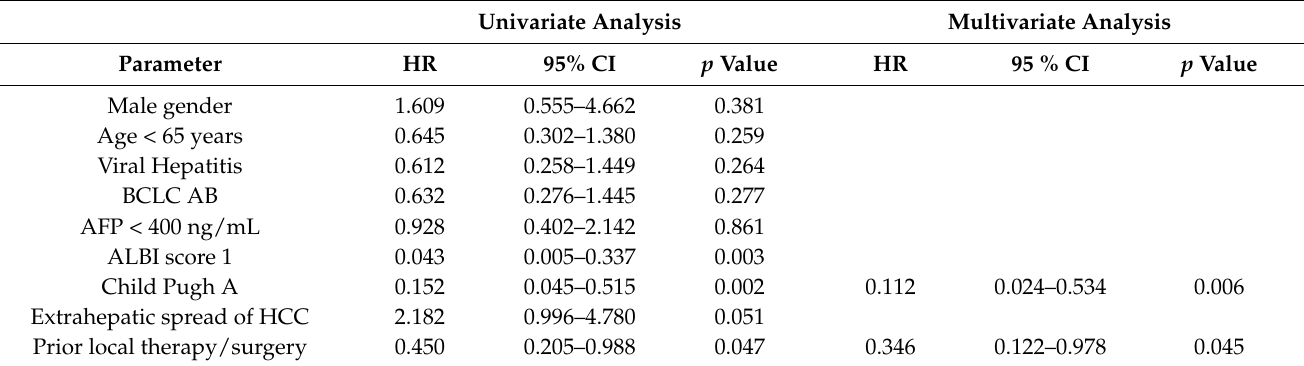
Table 4. Univariate and multivariate analyses of parameters associated with overall